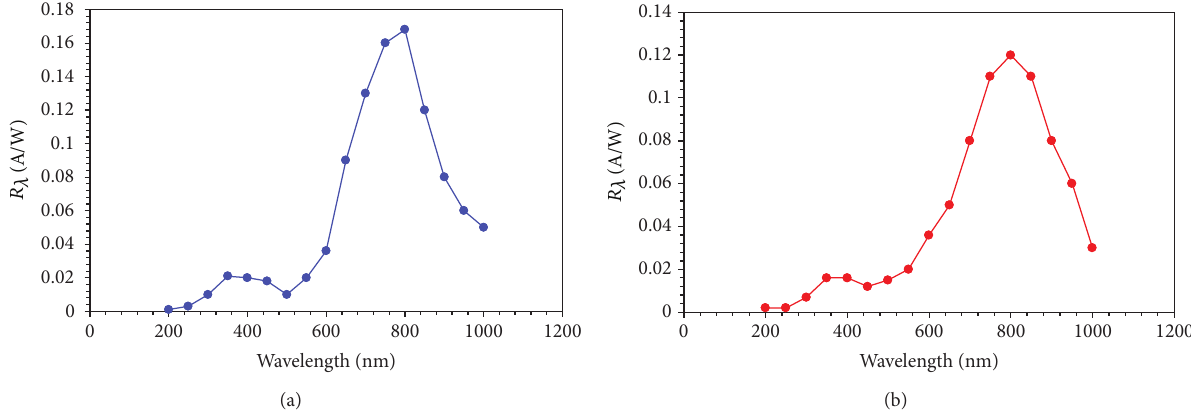
Figure 9: The spectral responsivity as a function of the incident wavelength. (a) (n-SnO 2 /n-Si) device, (b) (n- SnO 2 /p-Si) MIS device.